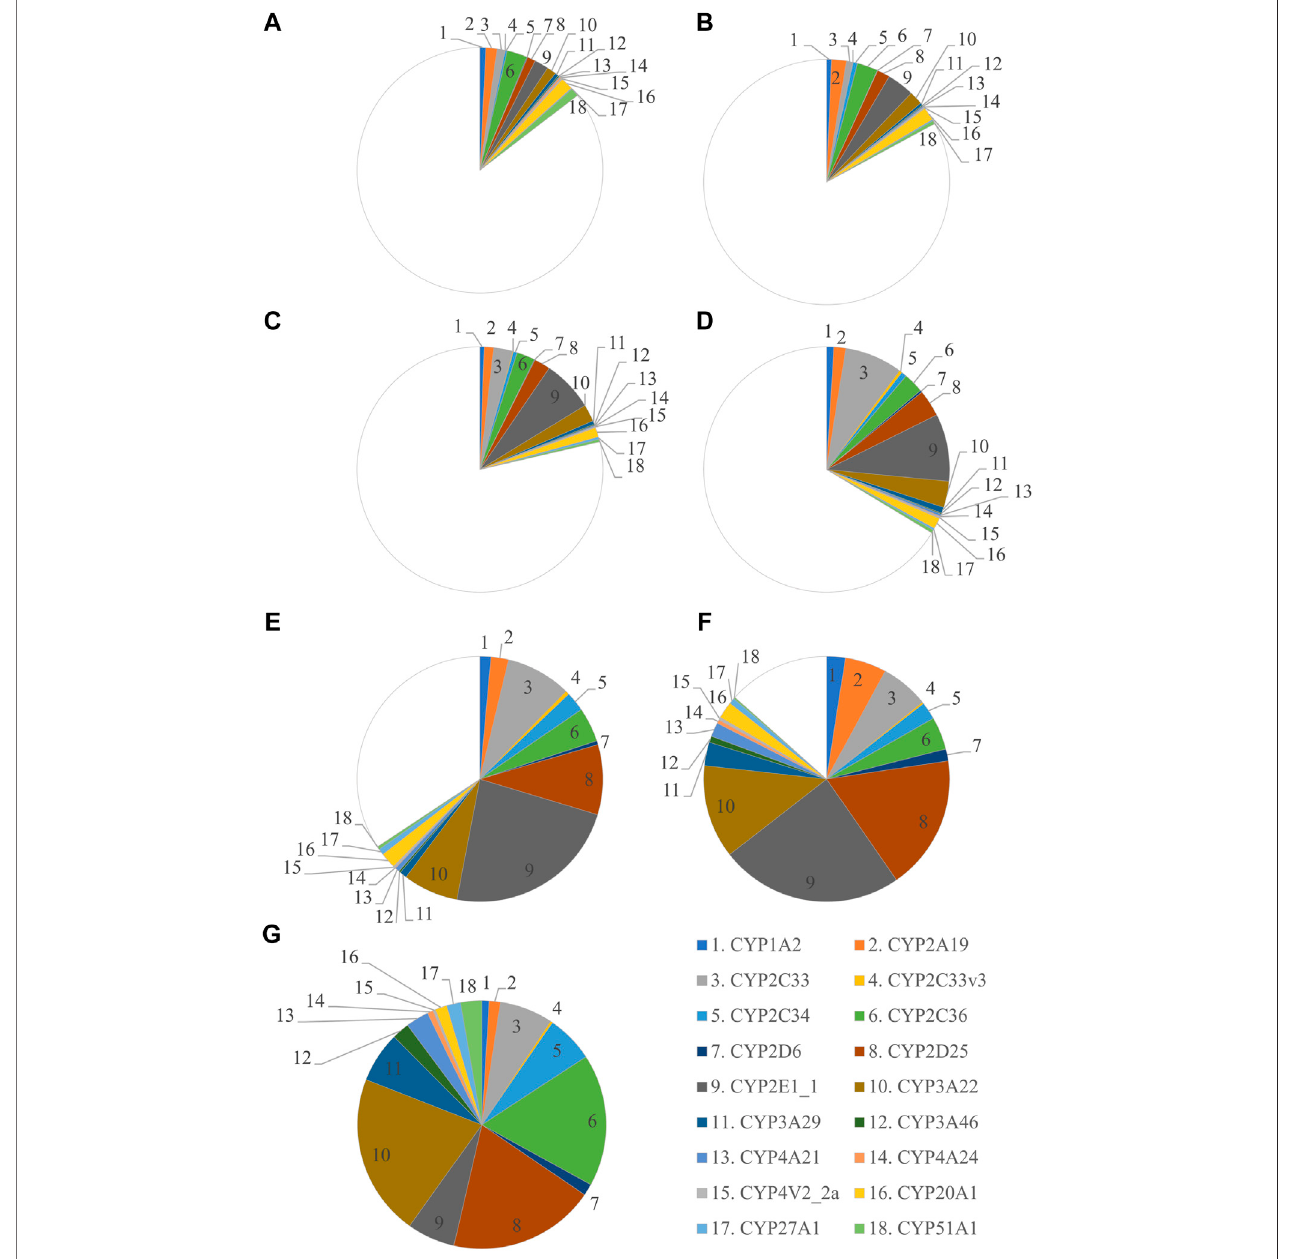
FIGURE 1 | Ontogeny of CYP protein abundance in the developing and adult male Göttingen Minipig. The protein abundance in the male adult samples is considered as the reference and is depicted as a full pie of 100%. The different age groups are represented by GD 84 – 86 (A) , GD 108 (B) , PND 1 (C) , PND 3 (D) , PND 7 (E) , PND 28 (F) and adult male (G)